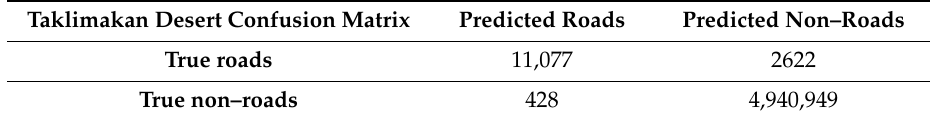
Table 8. Confusion matrix for true and detected roads calculated for the same area as in Figures 17–19.